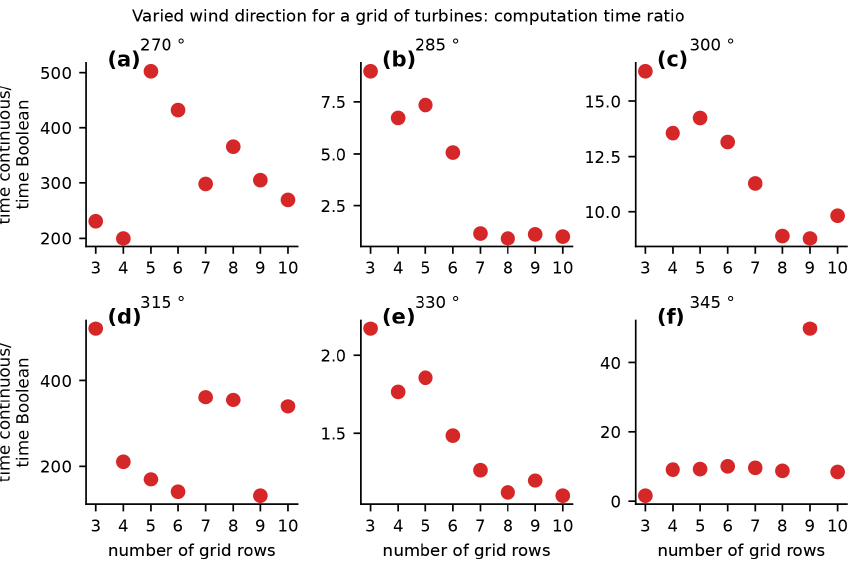
Figure 8. Comparison of the time required to solve the plant yaw angle optimization problem with yaw angles optimized with a traditional continuous approach compared to our novel Boolean optimization. These results are for a grid wind power plant for which, within each panel, the x axis indicates different numbers of rows in the plant. Each panel shows results for a different wind direction.